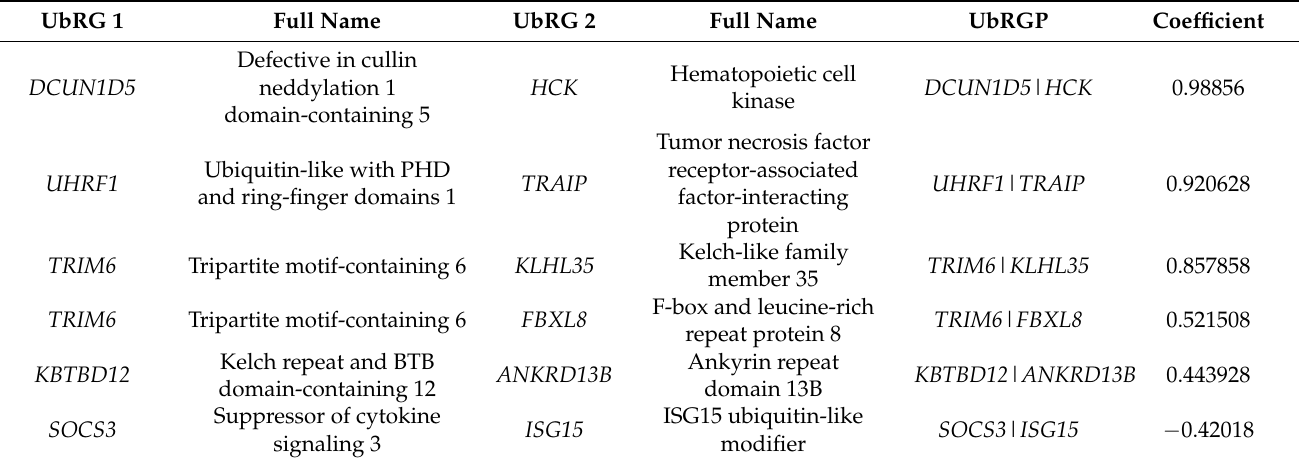
Table 2. The ubiquitin-related genes (UbRGs) used to construct the ubiquitin-related gene pairs